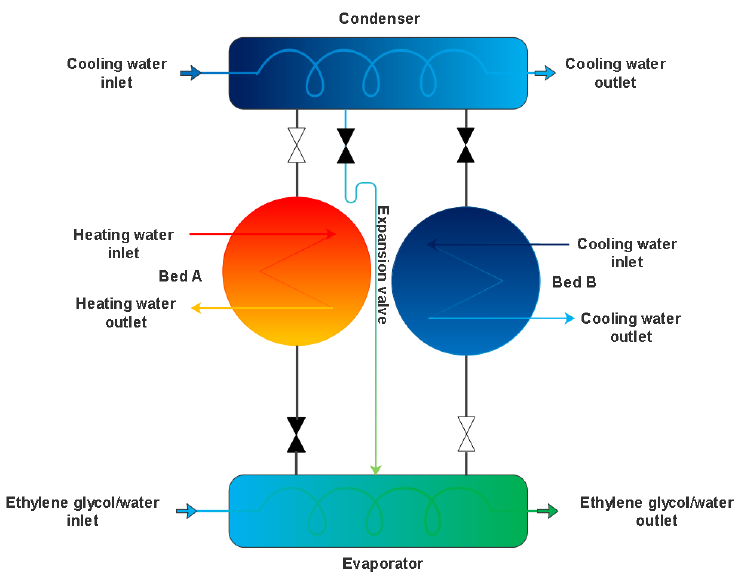
Figure 1. Schematic diagram of a two ‐ bed adsorption system used for ice